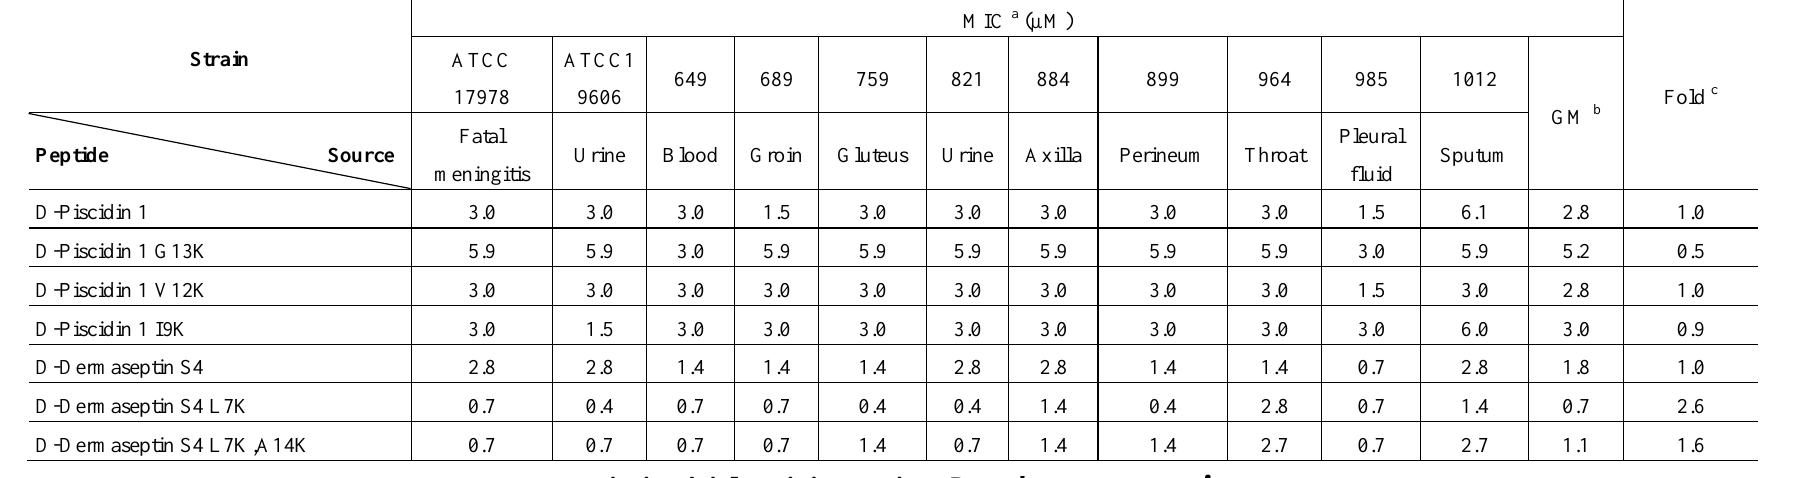
Table 3. Antimicrobial activity of D -piscidin 1 analogs and D -dermaseptin S4 analogs against A. baumannii (A) and P. aeruginosa (B) strains. A. Antimicrobial activity against Acinetobacter